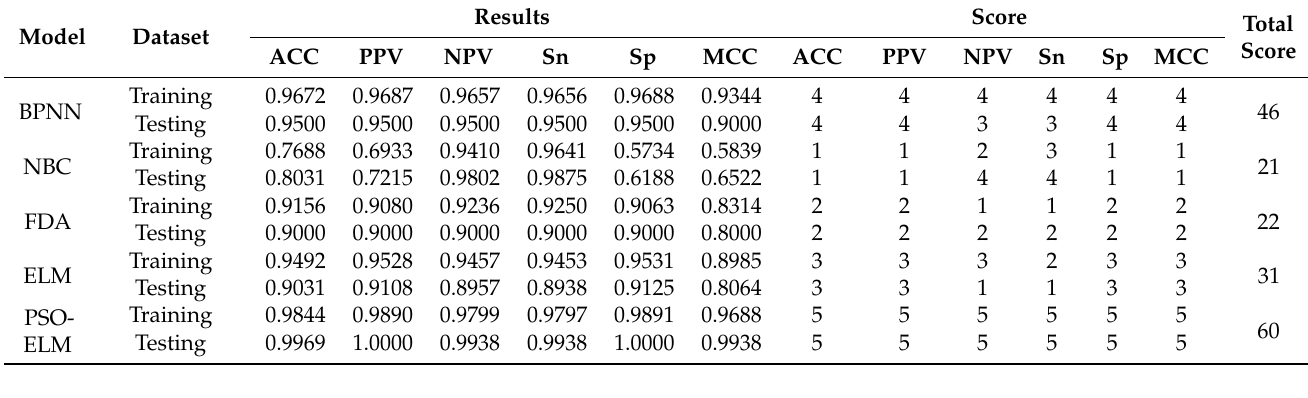
Table 2. Discrimination results for different discrimination models.